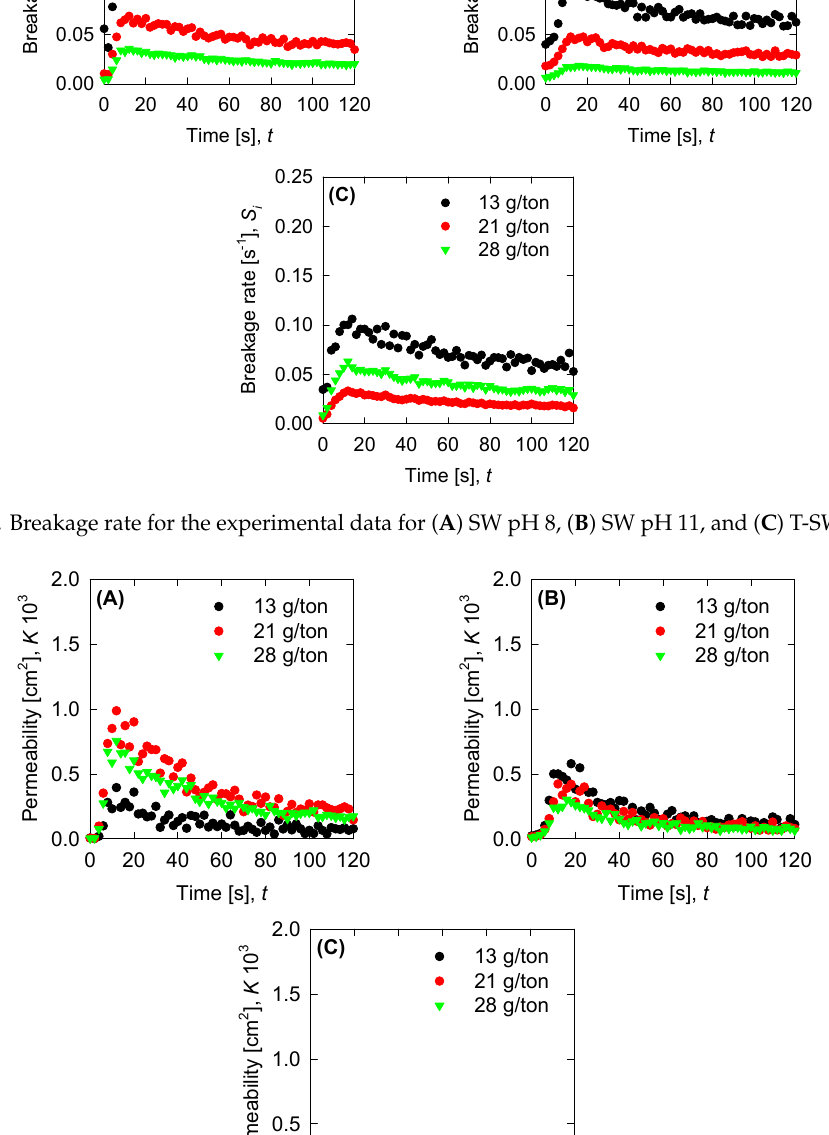
Figure 10. Permeability for the experimental data for ( A ) SW pH 8, ( B ) SW pH 11, and ( C ) T-SW pH